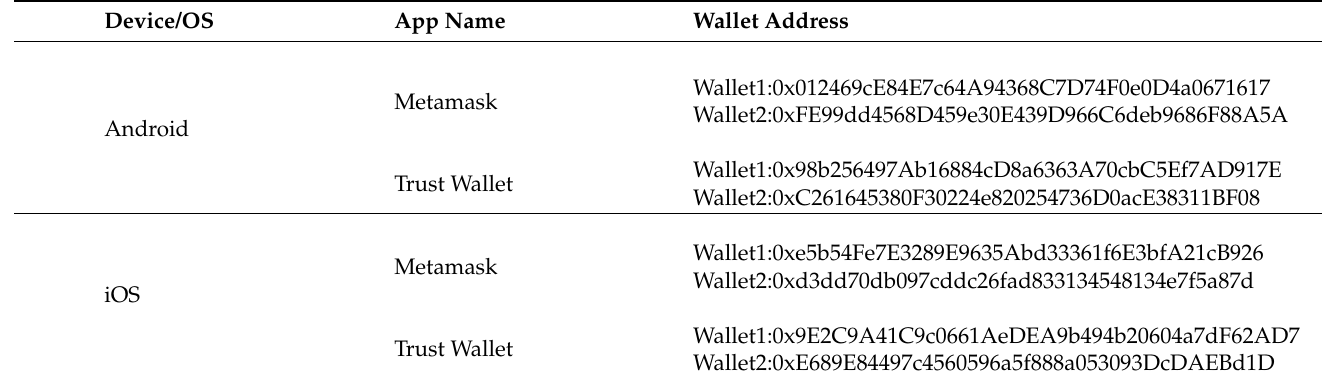
Table 6. Wallet addresses created in the study.